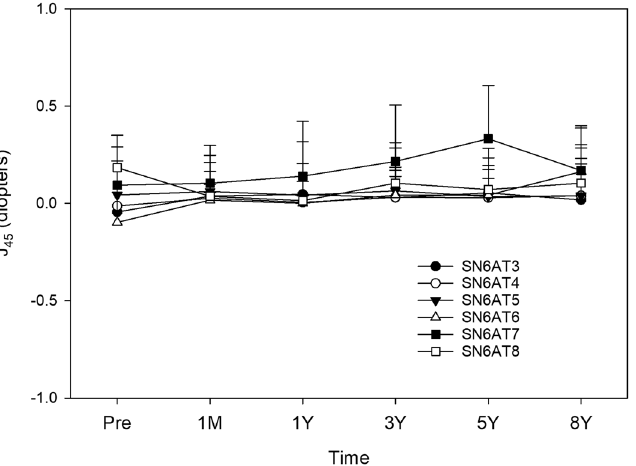
Figure 7. Time course of changes in J 45 by the model of toric IOLs. Postoperative J 45 values were not different among the models ( p > 0.05).